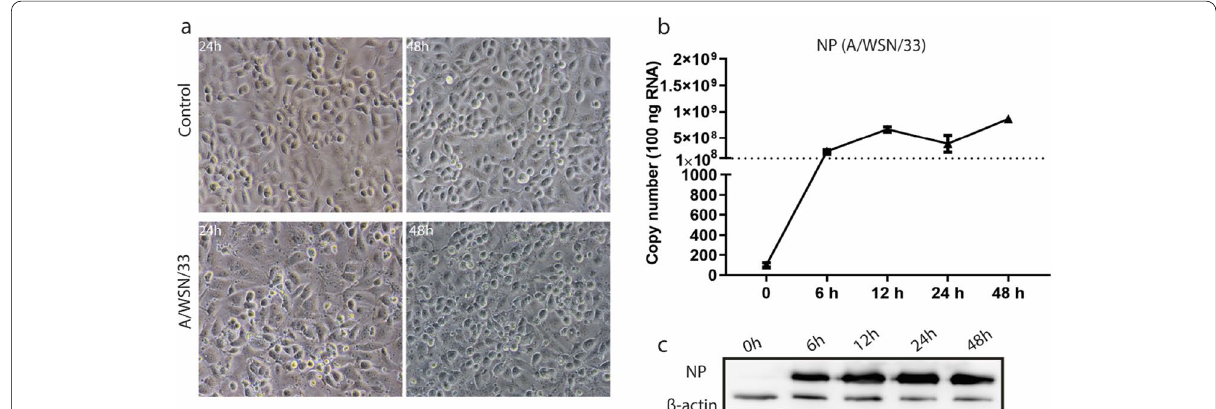
Fig. 1 Influenza virus entry and infection to human brain microvascular endothelial cells (hBMECs). a Phase-contrast (Ph) microscopy visualization of hBMECs morphology infected by A/WSN/33 (H1N1) at 0.1 multiplicity of infection (MOI). b RNA extracted from hBMECs and targeted by RT-qPCR to detect NP gene expression at different time points, error bars indicate standard deviation. c the cells were lysed for NP detection by western blotting at indicated time points post-infection. Data were shown as means SEM from three experiments, and statistical significance analyzed by ± t-test * p < 0.05, *** p < 0.001